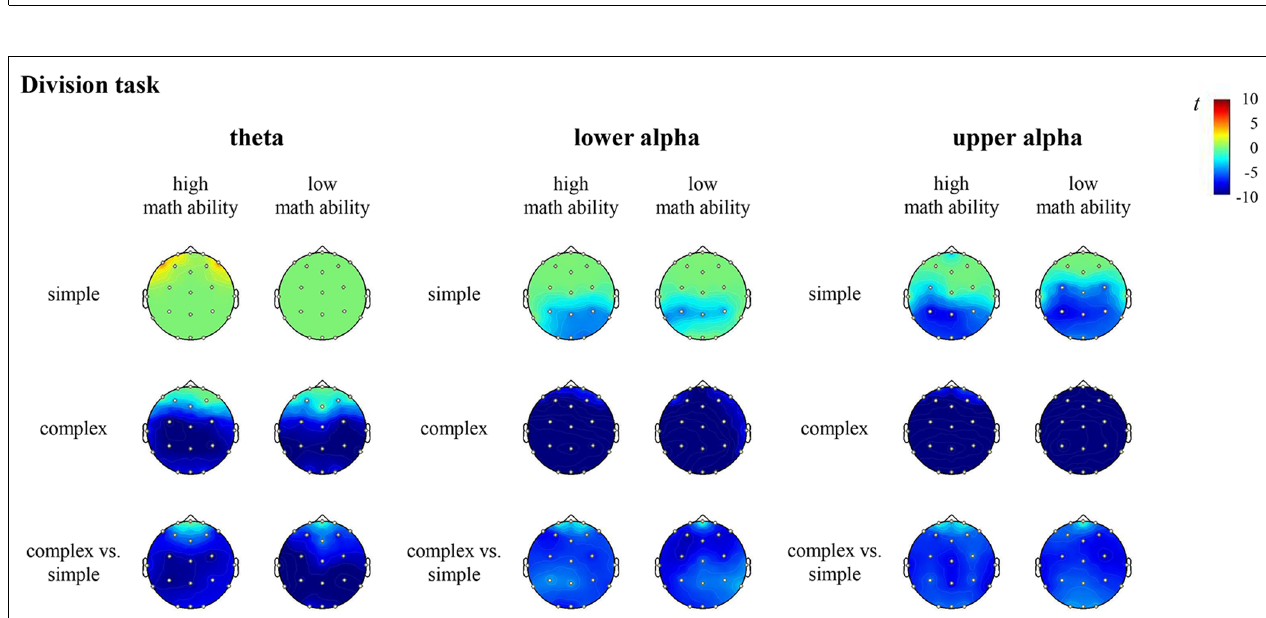
FIGURE 5 | T maps for the electroencephalography (EEG) data depicting theta, lower and upper alpha (de)synchronization during the multiplication task for simple arithmetic problems, complex arithmetic problems and the contrast (complex vs. simple) for individuals with high math ability and low math ability. The colors indicate synchronization (yellow-red) and desynchronization (light-dark blue), respectively.